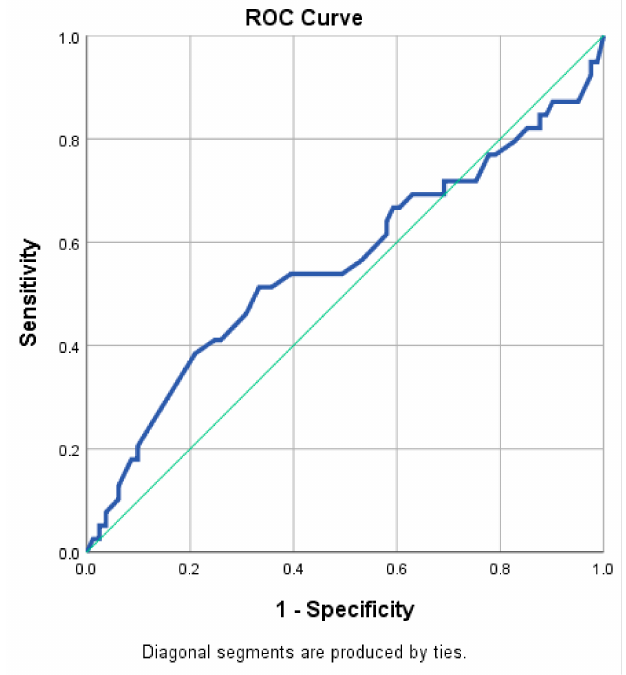
Figure 2. Receiver operating characteristic (ROC) curve for specified income